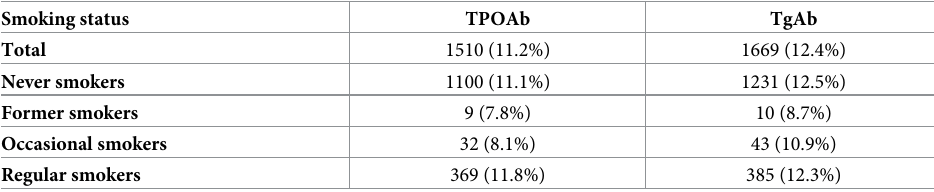
Table 3. The proportion of TPOAb positivity and TgAb positivity among different smoking status groups. Smoking